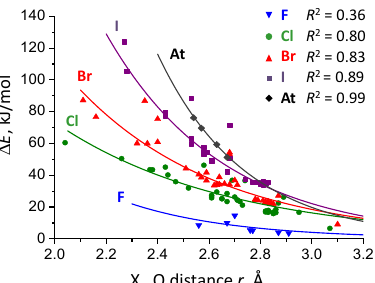
Figure 4. Correlation between calculated complexation energy ∆ E and interatomic distance r (X ··· O, where X = F, Cl, Br, I, At) for R–X ··· O = PMe 3 halogen-bonded complexes studied in this work. The solid curves correspond to Equation (1).